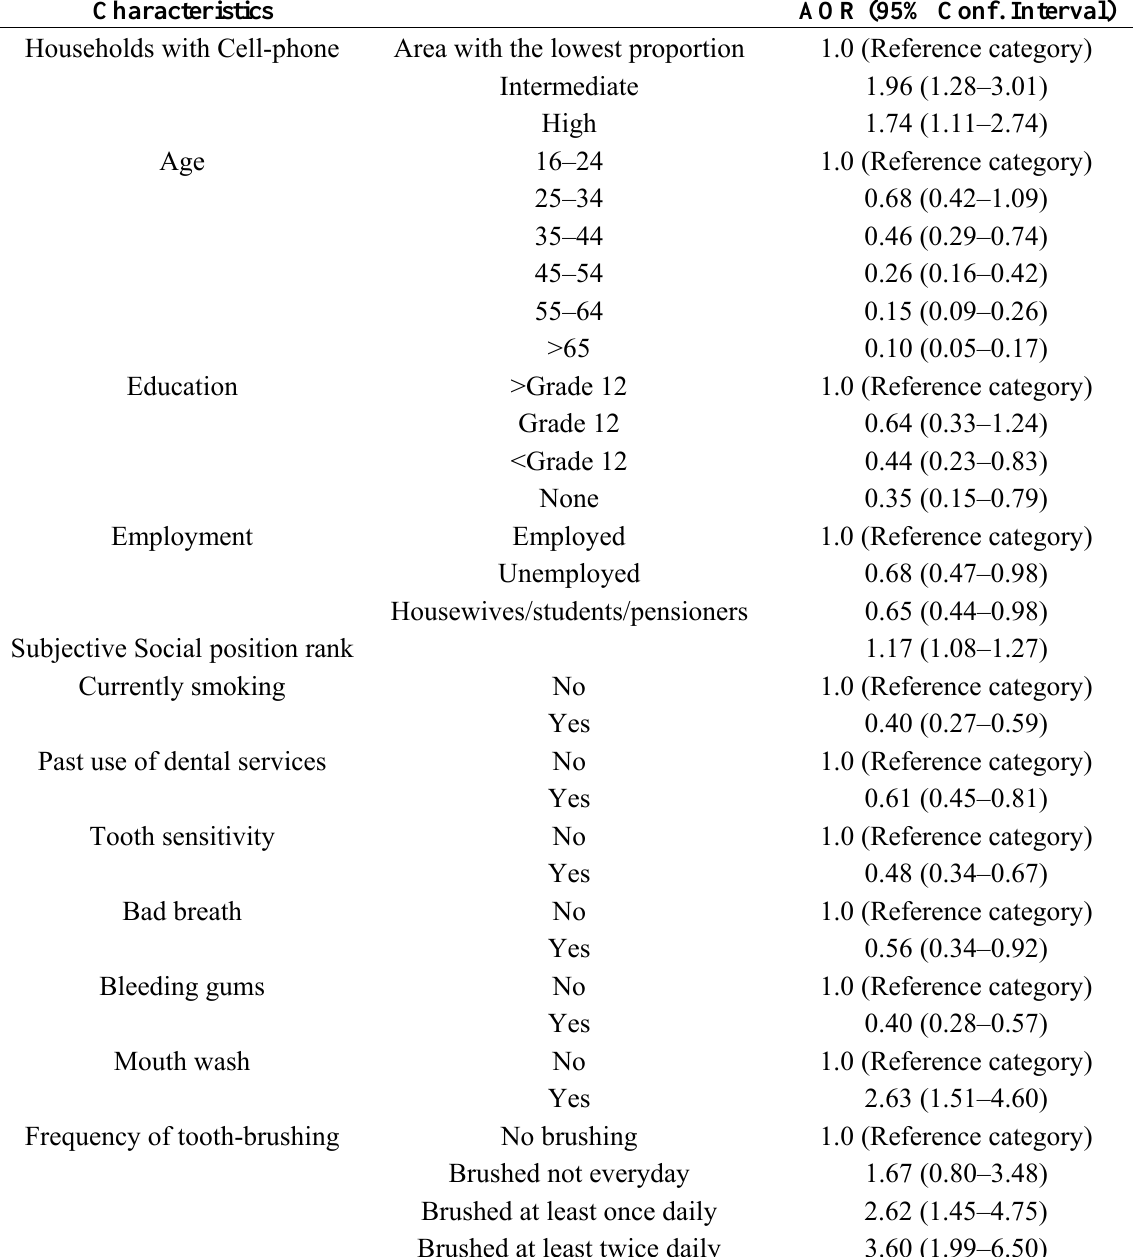
Table 5. Multilevel model of determinants of self-rated good oral health among